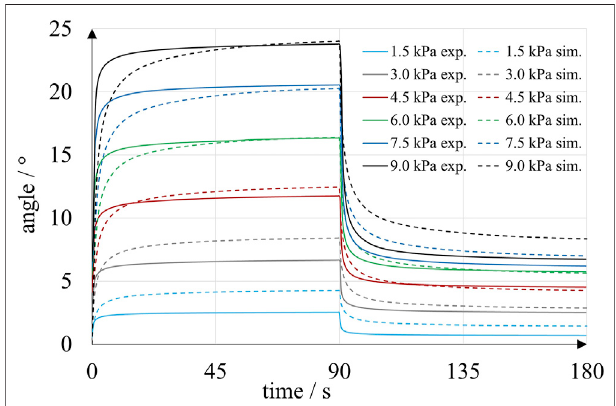
FIGURE 13 | Time-dependent angular position of inkjet-printed rotary bellows actuators in experiments (solid lines) and simulation (dashed lines). Each solid curveis an average of fi ve experiments with four bellows chambers at a particular pressure